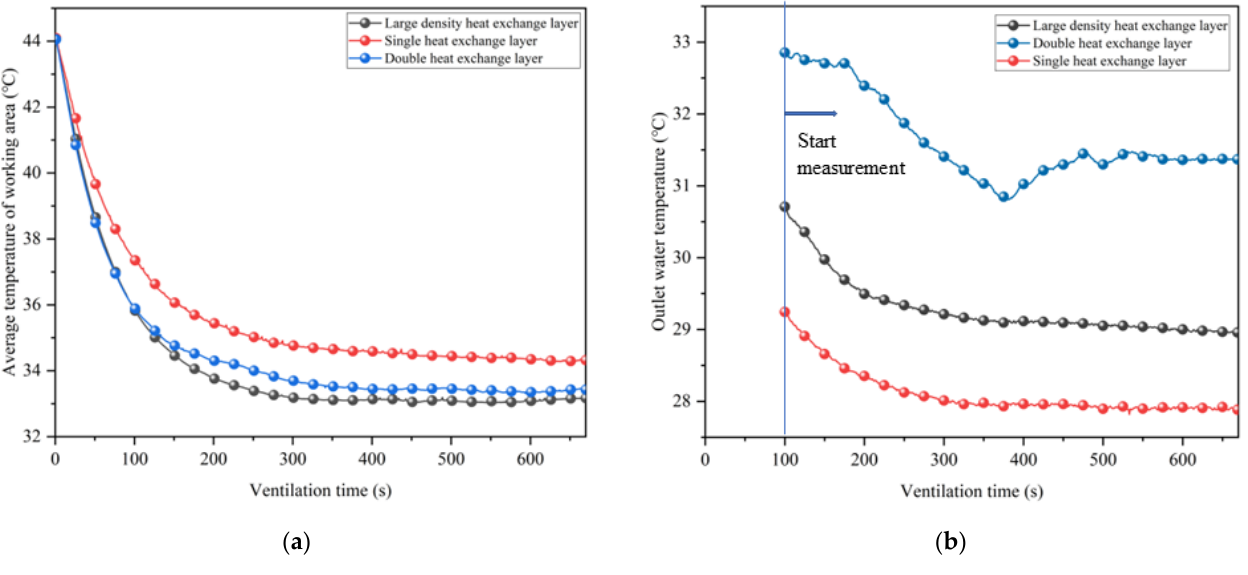
Figure 14. Average temperature of working area and water at different heat exchange pipe density: ( a ) Average temperature; ( b ) Water temperature. ( a ) Average temperature; ( b ) Water